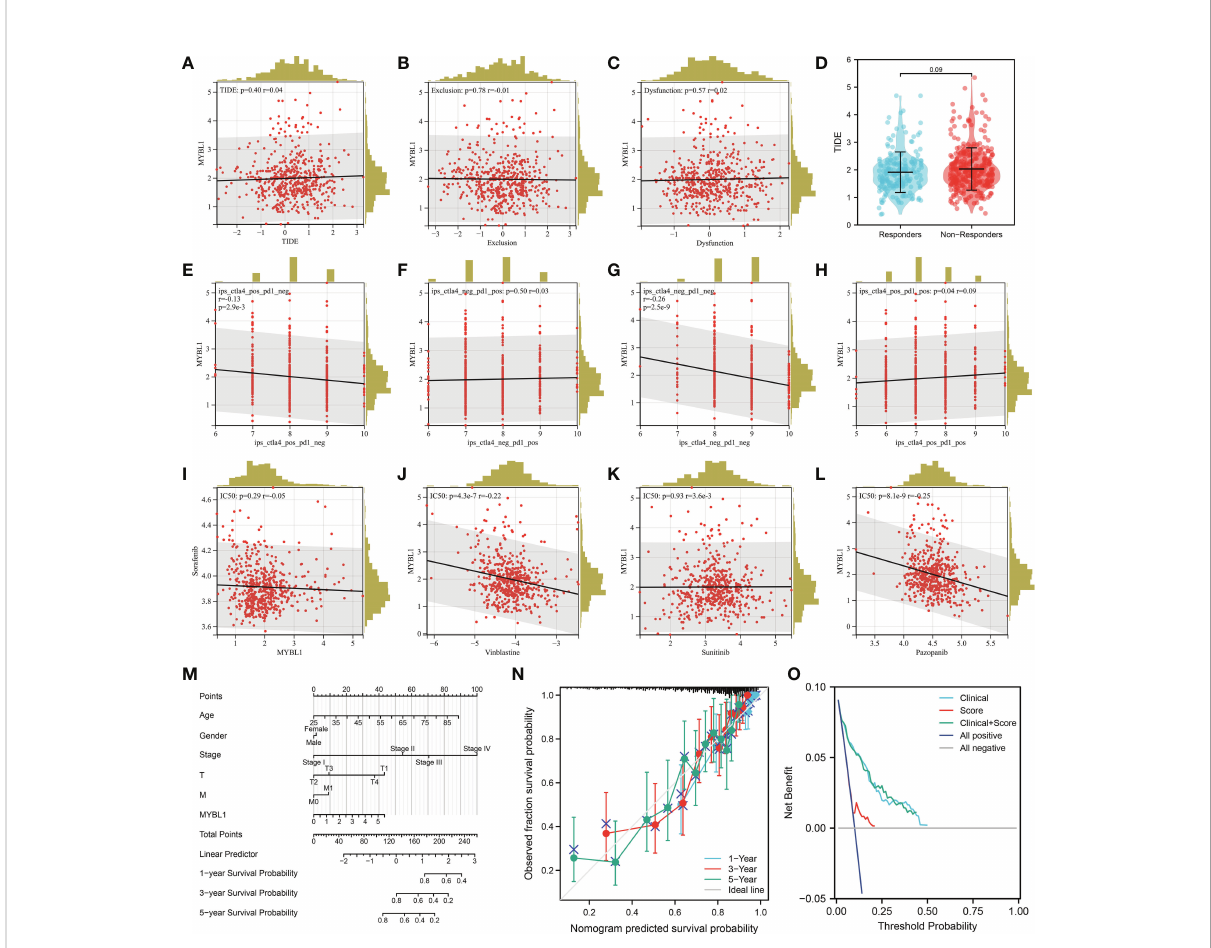
FIGURE 5 Immunotherapy and drug sensitivity of MYBL1. (A) Correlation of MYBL1 with TIDE; (B) Correlation of MYBL1 with immune exclusion; (C) Correlation of MYBL1 with immune dysfunction; (D) The MYBL1 expression in immunotherapy responders and non-responders; (E – H) Correlation of MYBL1 with IPS score; (I – L) Correlation of MYBL1 and drug sensitivity; (M) The nomogram plot based on MYBL and nomogram plot; (N) The calibration curve; (O) The DCA